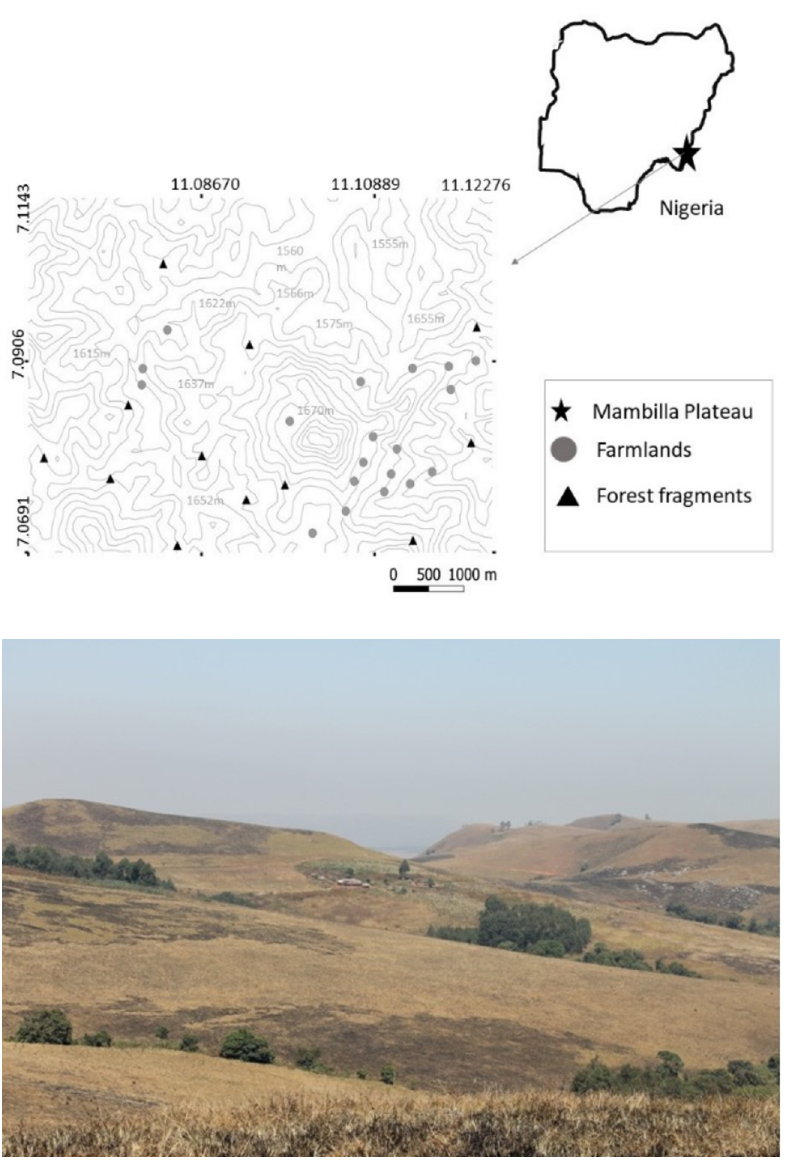
Fig 1. The study area. (A) Map of Nigeria and the location of the experimental site on Mambilla Plateau, Nigeria. (B) The study landscapes. Montane Forest Project (Fig 2A). Each seed species was planted into 45 polypots making a total of 90 polypots (three seeds/bag). The seeds were protected from birds and rodents using a cage of wire netting with pore size of 0.8 mm x 1.2 mm. The seeds germinated approximately 10 days after sowing, with germination of all seeds complete after 15 days. Three weeks after planting, we moved them into 10 farmlands and placed them along 15 line transects, with each transect measuring 300 m, making a total of 4500 m of transects. Five farmlands had two tran- sects each and the other five farmlands had one transect each, depending on the size of farm- land. The distance between transects was at least 150 m. We placed one groundnut plant and one bambara nut plant in each section, with a minimum increasing distance of 50 m across